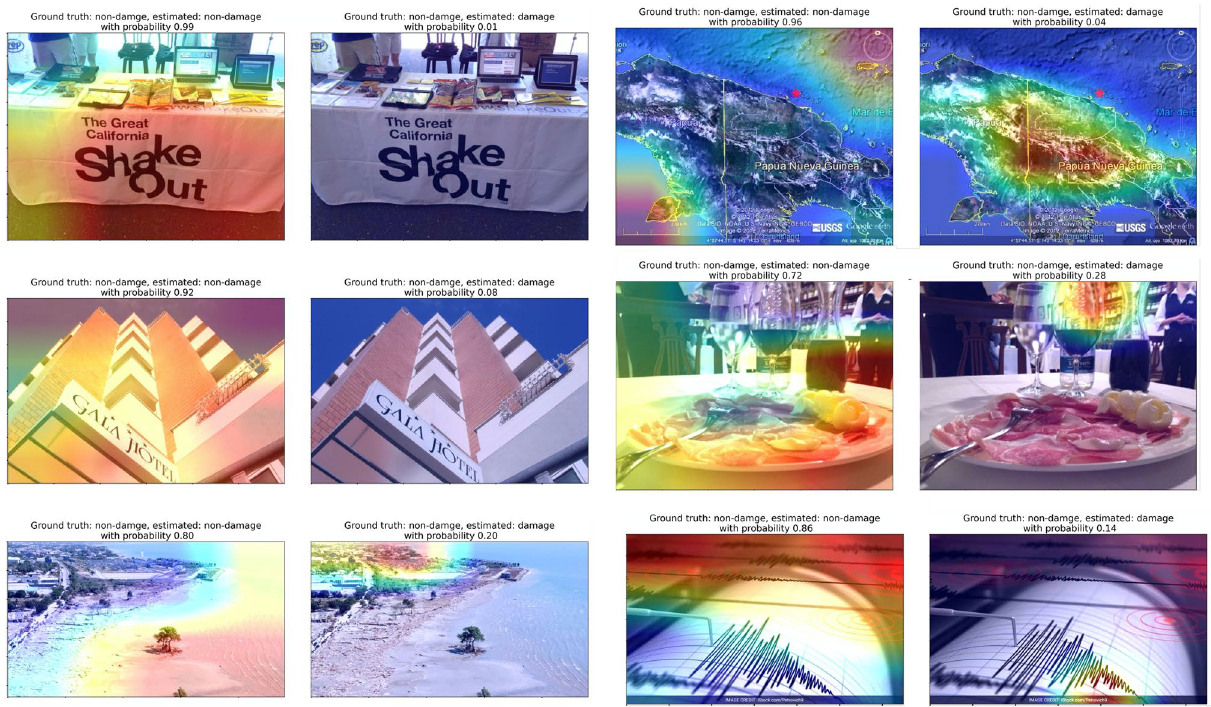
Figure 6. Grad-CAM heatmap on images that the model made the correct decision for non-damage class (True Negatives) . Heatmap overlaying images indicates where the model pays more attention when making the decision; warmer colors indicate stronger influence on the decision. Each image is shown twice and overlaid with a heatmap indicating the regions of the image that suggest building damage, and the regions that suggest no building damage. The ground truth, estimated label and estimated probability is shown in the title above each